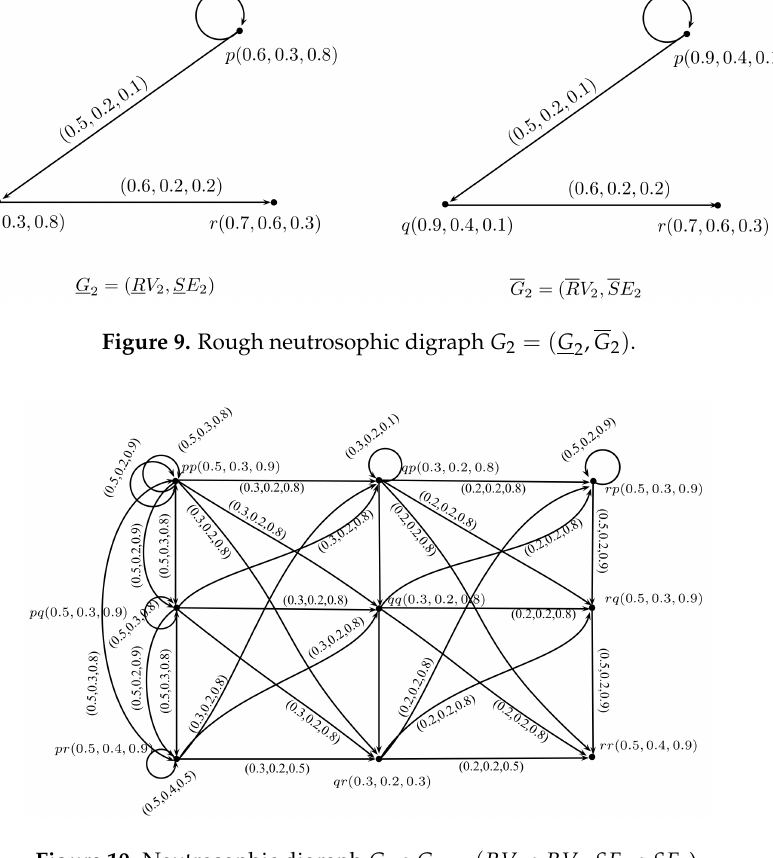
Figure 10. Neutrosophic digraph G 1 ◦ G 2 = ( RV 1 ◦ RV 2 , SE 1 ◦ SE 2